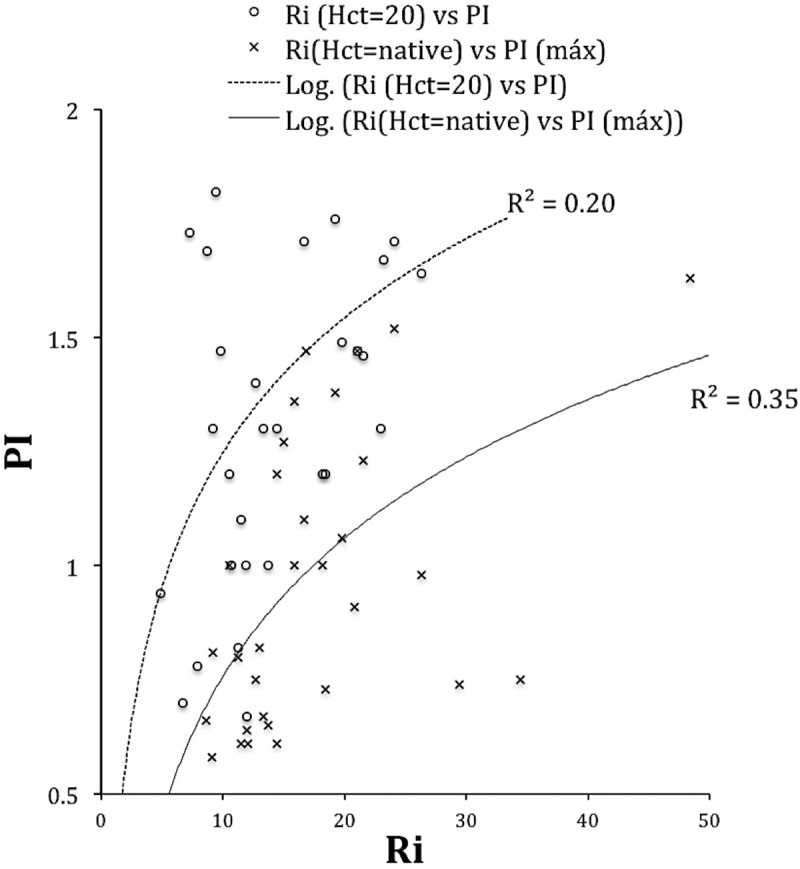
Relationship between values of Ri measured with Hct = 20 (n = 36) and Ri measured with Hct = native.Patients (M&F): SS: 32, SC: 2; Sbeta0thal: 1, SD: 1, R2 values shown in graph; Ri measurements at 37 oC. Adjustment performed with power curve for Ri (Hct = 20).